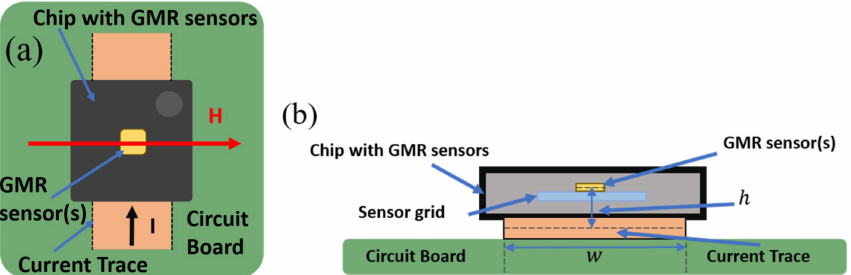
Figure 1. Non-contacting current measurement basic setup using a conducting trace and a giant magnetoresistance (GMR) based sensor chip: ( a ) plane view; ( b ) cross section (adapted from [17]). The current, I , from the conductive trace (denoted as “Current trace”) generates a magnetic field, whose component, B x , will be detected by the GMR sensor. To estimate B x , we derived an analytical method, which assumes that the sensor is centered above the trace at distance h , Figure